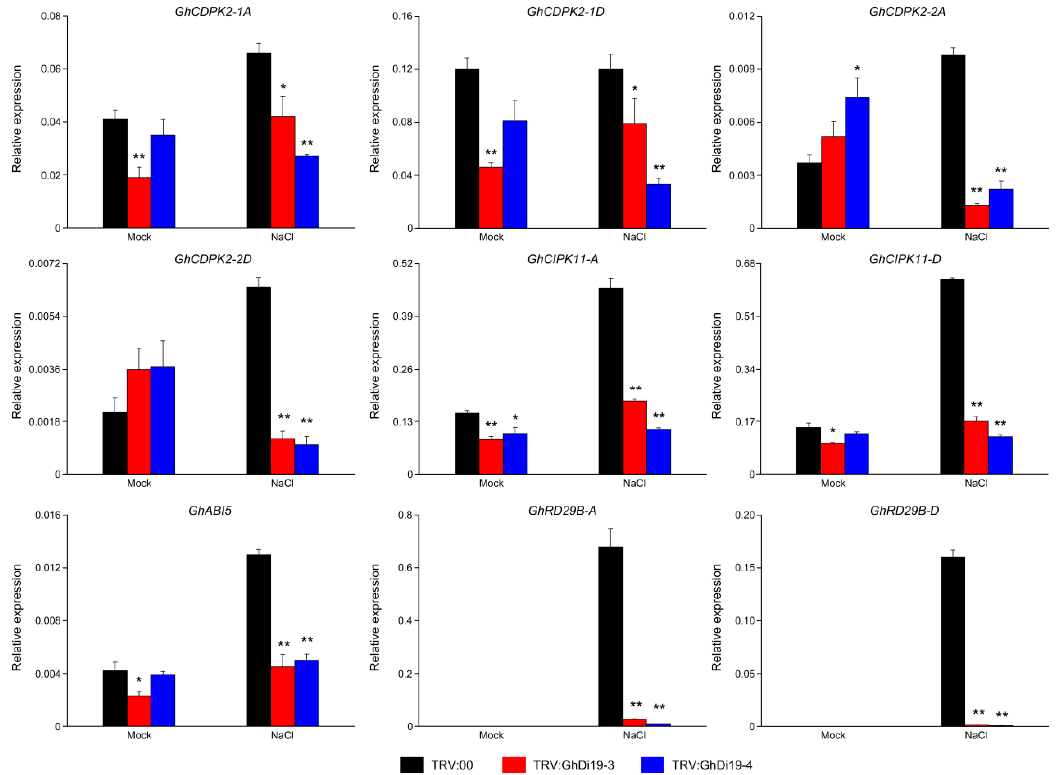
Figure 7. qRT-PCR analysis of calcium signaling related and ABA-responsive genes under simu- lated salt stress in the control and GhDi19-3 - and GhDi19-4 -silenced plants. Transcript levels of GhCDPK2-1A , GhCDPK2-1D , GhCDPK2-2A , GhCDPK2-2D , GhCIPK11-A , GhCIPK11-D , GhABI5 , GhRD29B-A , and GhRD29B-D genes were determined by qRT-PCR, using GhUBQ7 gene as the reference. Asterisks indicate significant differences (independent t-tests): *, p < 0.05; **, p < 0.01.